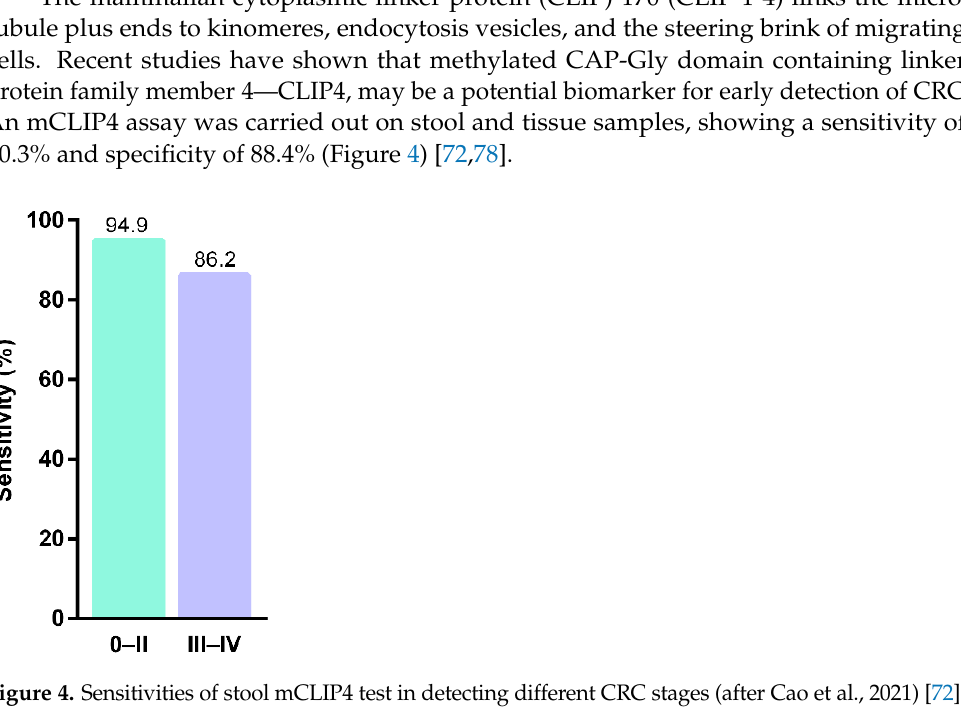
Figure 5. Comparison of CTCF-binding site markers with existing markers (after Liu et al., 2017) [92].